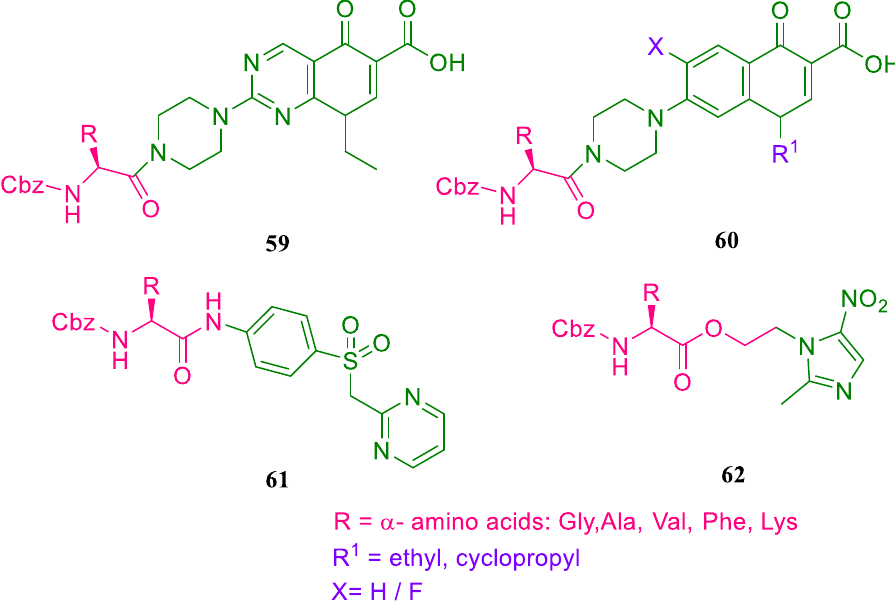
Figure 53. Amino acid conjugated to metronidazole/sulphadiazine/quinolone. Sreelatha T et al. synthesised four series of naphthoquinone amide derivatives ( 63 ) of the bioactive quinones, such as plumbagin, juglone, menadione and lawsone, which